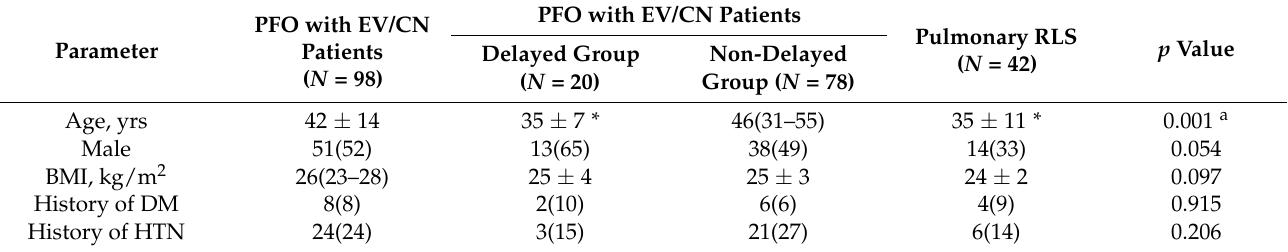
Table 1. Patients Baseline Parameters.